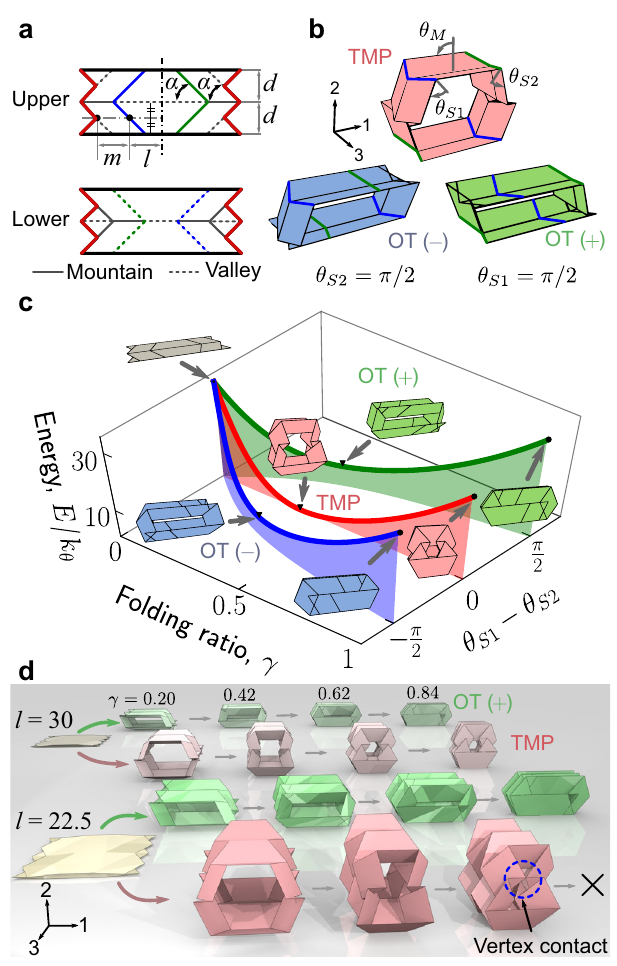
Fig. 1 Recon fi gurable rigid origami structure. a The fl at crease patterns of the origami unit cell, and b three possible phases: TMP, OT( − ) and OT( + ). When crease lines denoted by blue (green) color are forced to be fl at, unit cell is folded into OT( + ) (OT( − )). c Recon fi gurable behavior is shown in the con fi guration space. Energy landscape for each con fi guration is plotted along its folding path. The geometrical parameters are ( l , m , d , α ) = (30,30,30,65°) (see Supplementary Note 1 for the detail of the energy calculation). d Folding motion of TMP and OT( + ) with l = 30 (back) and l = 22.5 (front). The other parameters are the same as those in c